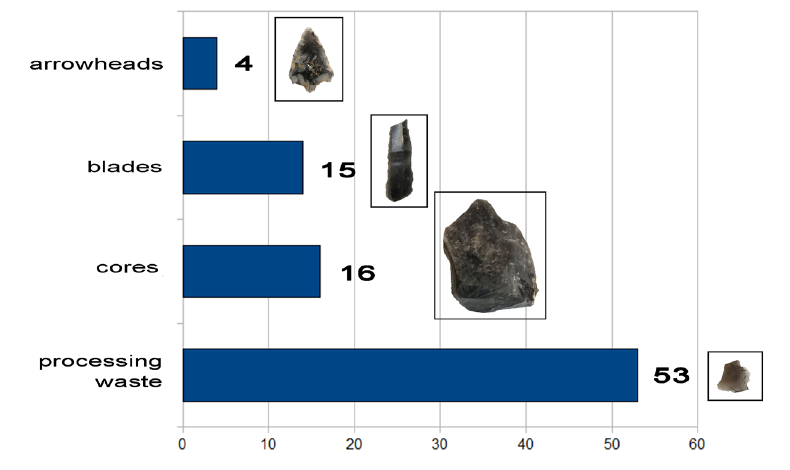
Figure 4. Graph–typological the largest obsidian artifacts groups analyzed in the S–F area.